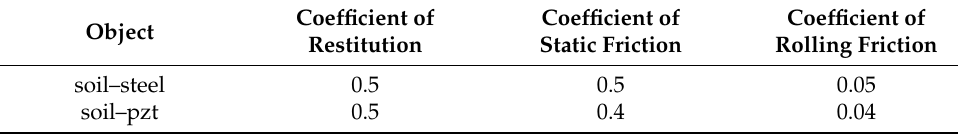
Table 2. Contact parameters.